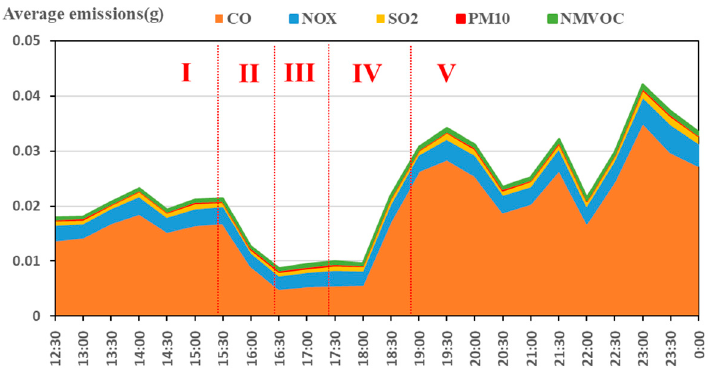
Figure 8. Dynamic variance of daily traffic flow average emissions on Minnesota freeway.